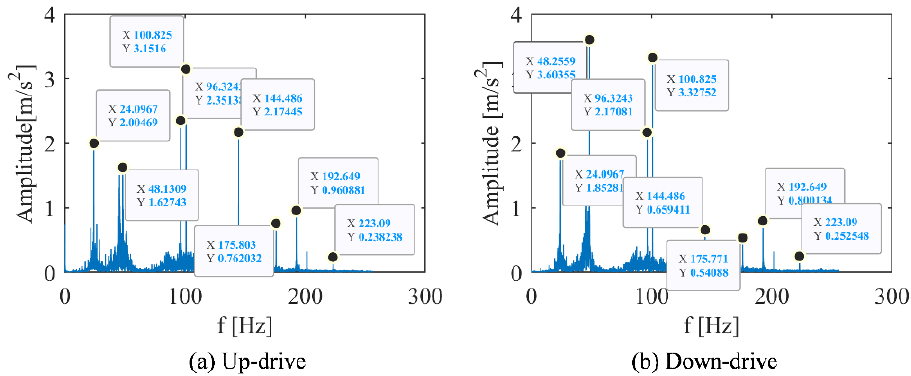
Figure 5. Vibration spectrum of main engine in different running directions of elevator (2.4 m/s). ( a ) Motor with up-drive condition. ( b ) Motor with down-drive ( a ) Motor with up-drive condition. ( b ) Motor with down-drive condition.